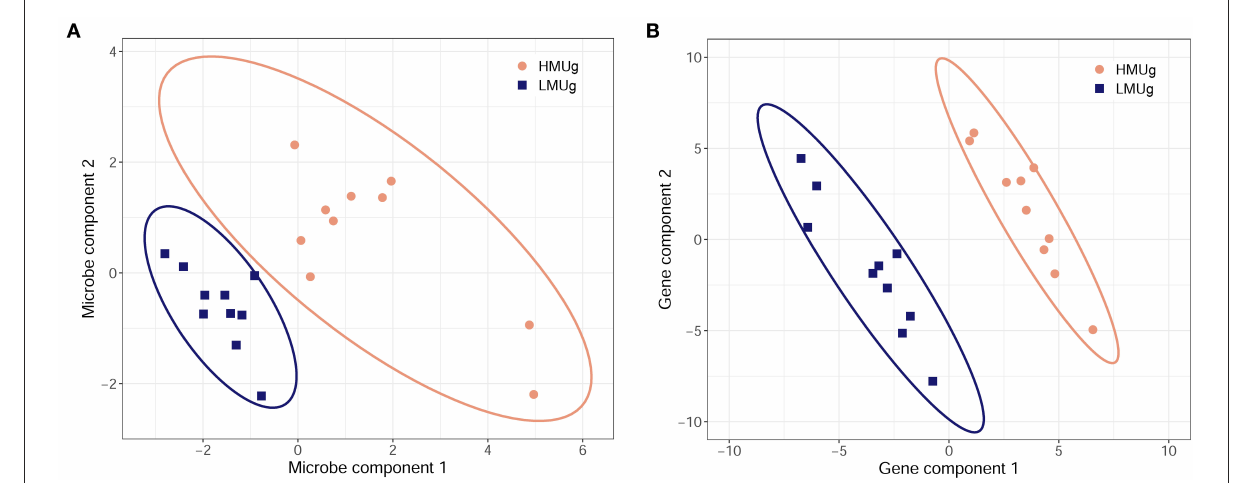
FIGURE2 Sparse partial least square-discriminant analysis of HMUg and LMUg cows, driven by (A) 53 key microbial genera in the rumen fluid and by (B) 100 key genes in the rumen tissue.